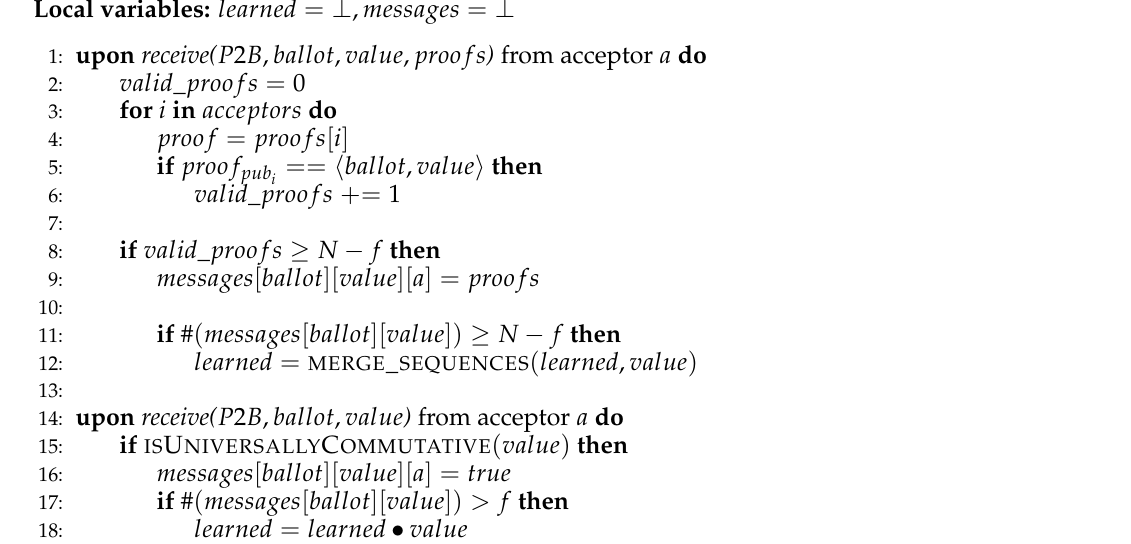
Algorithm 10 Byzantine Generalized Paxos—Learner